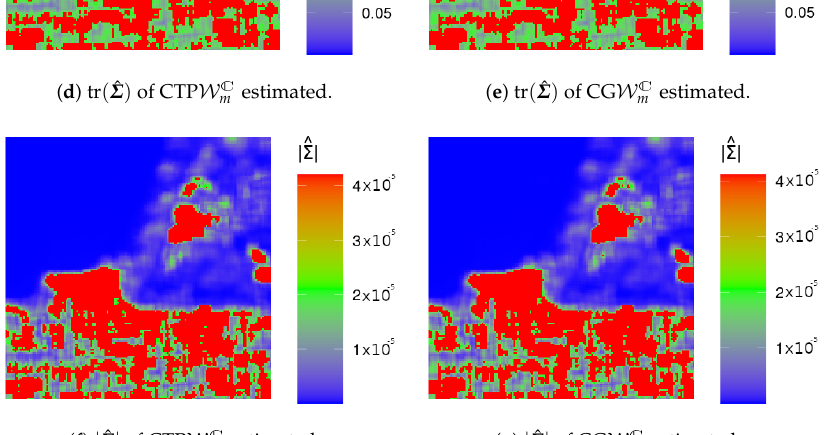
C are exhibited in Figure 5b,d,f, respec- m